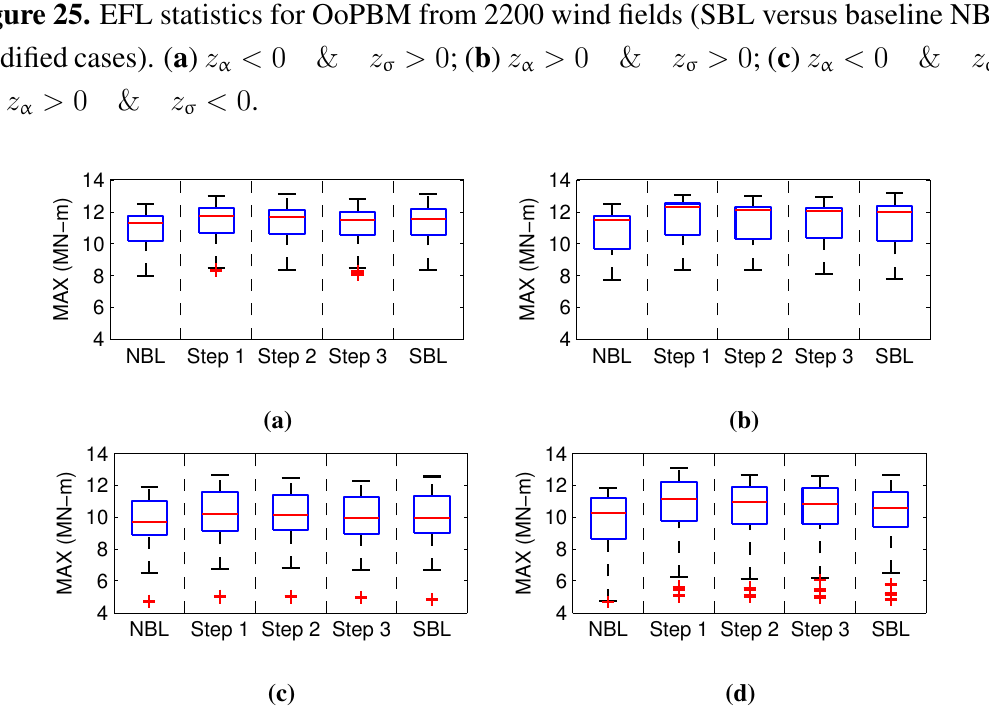
Figure 26. Ten-minute maximum statistics for OoPBM from 2200 wind fields (SBL versus baseline NBL and modified cases). ( a ) z